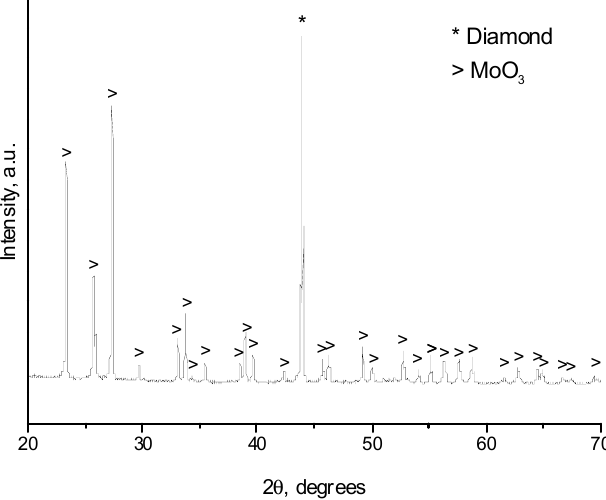
Figure 12. XRD pattern of the sample obtained at 650 °C, 60 min in air.